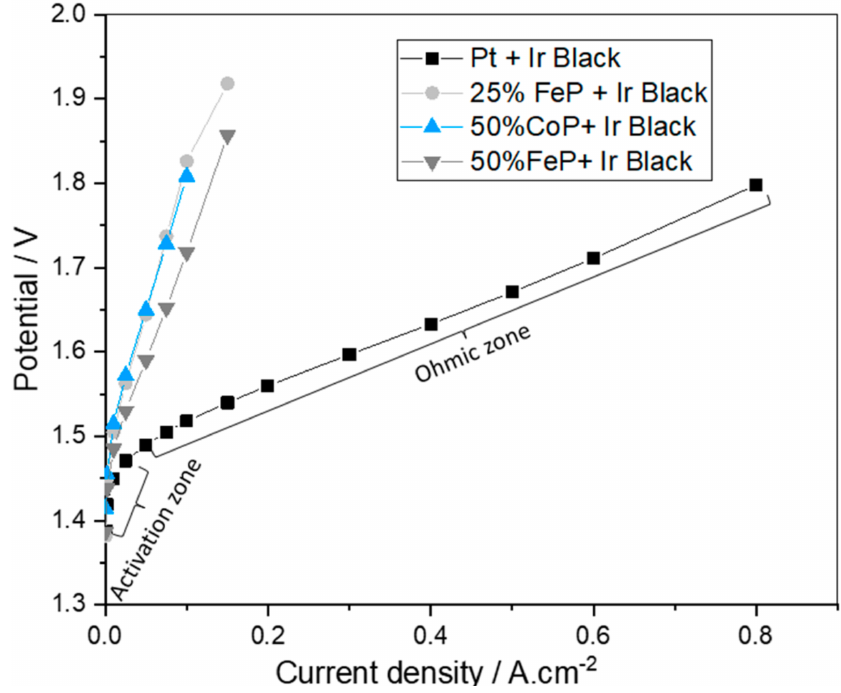
Figure 8. Polarization curves of the best developed catalysts (25% FeP/CB, 50% FeP/CB and 50% CoP/CB) and the state-of-the-art Pt/CB catalyst for the HER coupled with Ir black as the OER